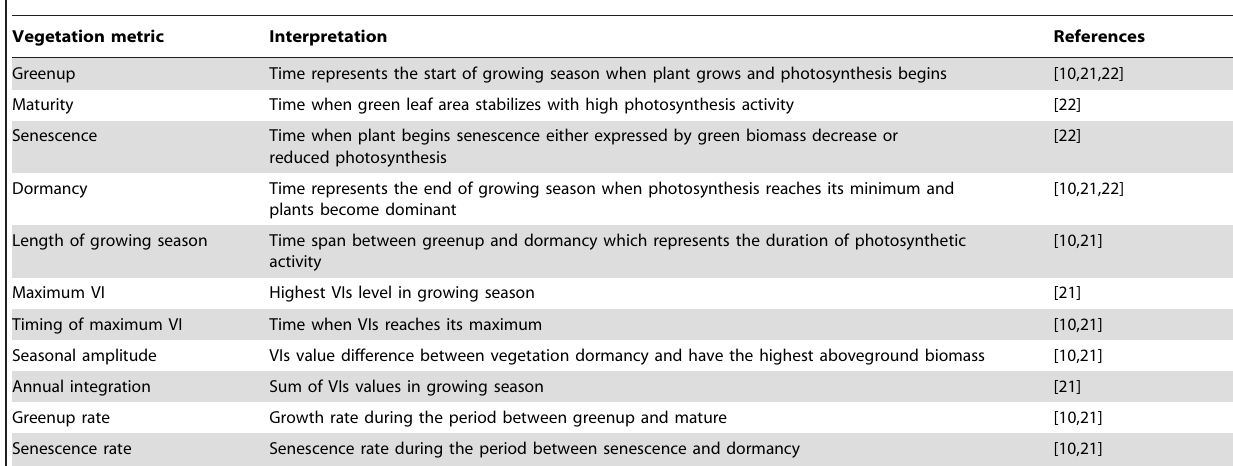
Table 1. Summary of vegetation metrics used in time series analysis.